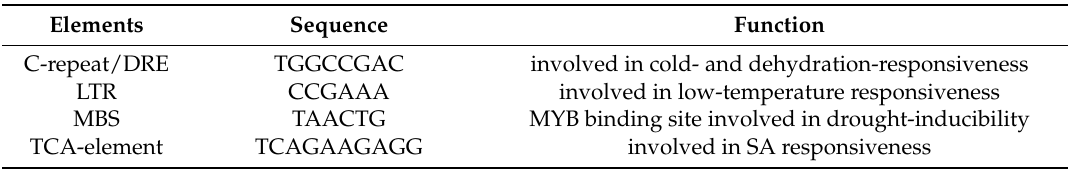
Table 1. Putative cis -elements in the ZmWRKY106 promoter.